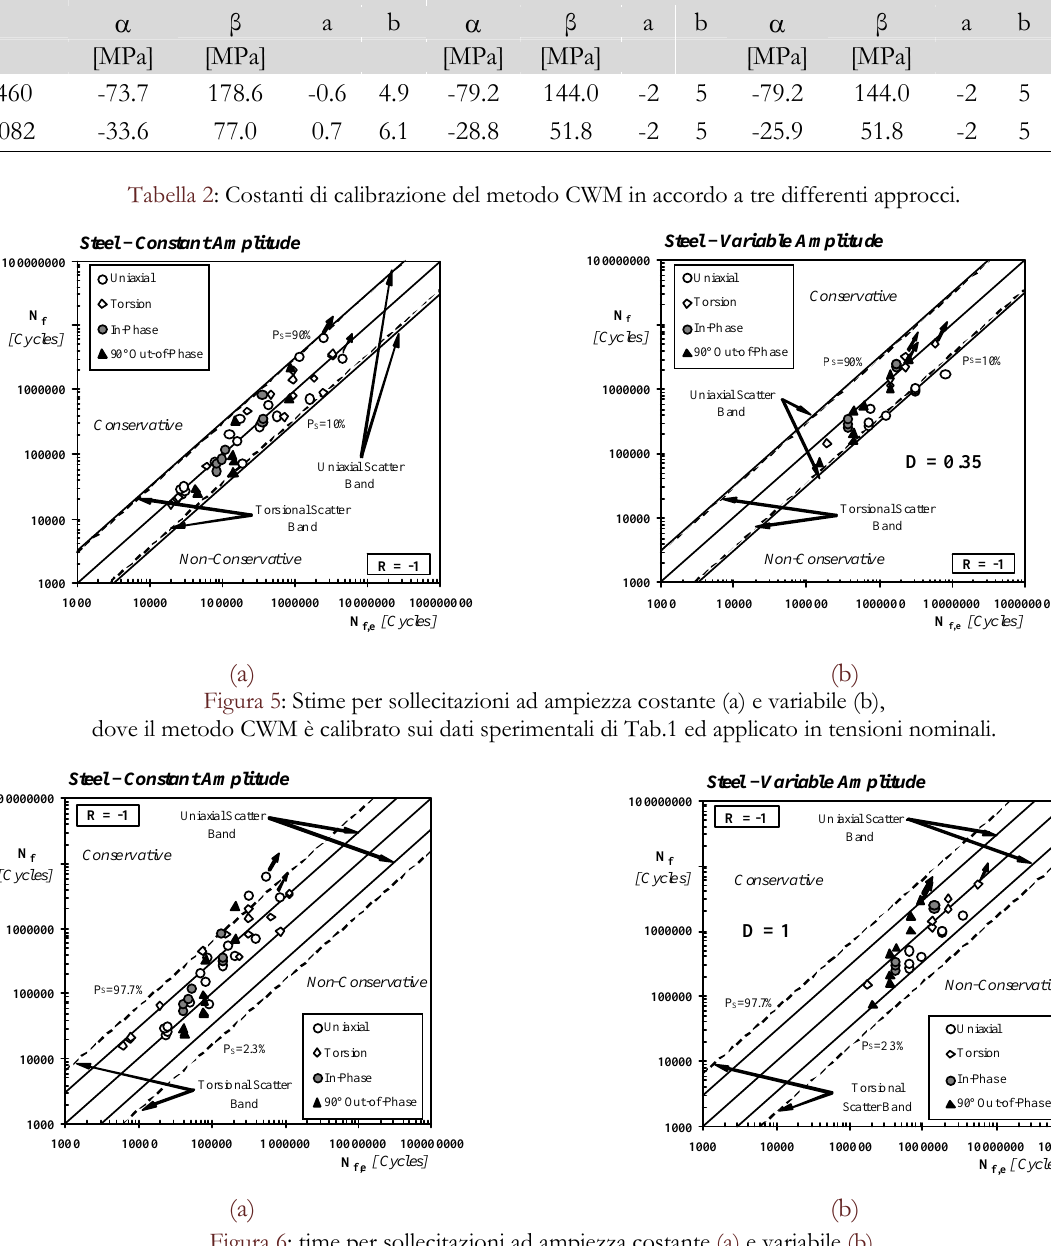
Figura 6: time per sollecitazioni ad ampiezza costante (a) e variabile (b), dove il metodo CWM è calibrato sulle curve di normativa IIW ed applicato in tensioni